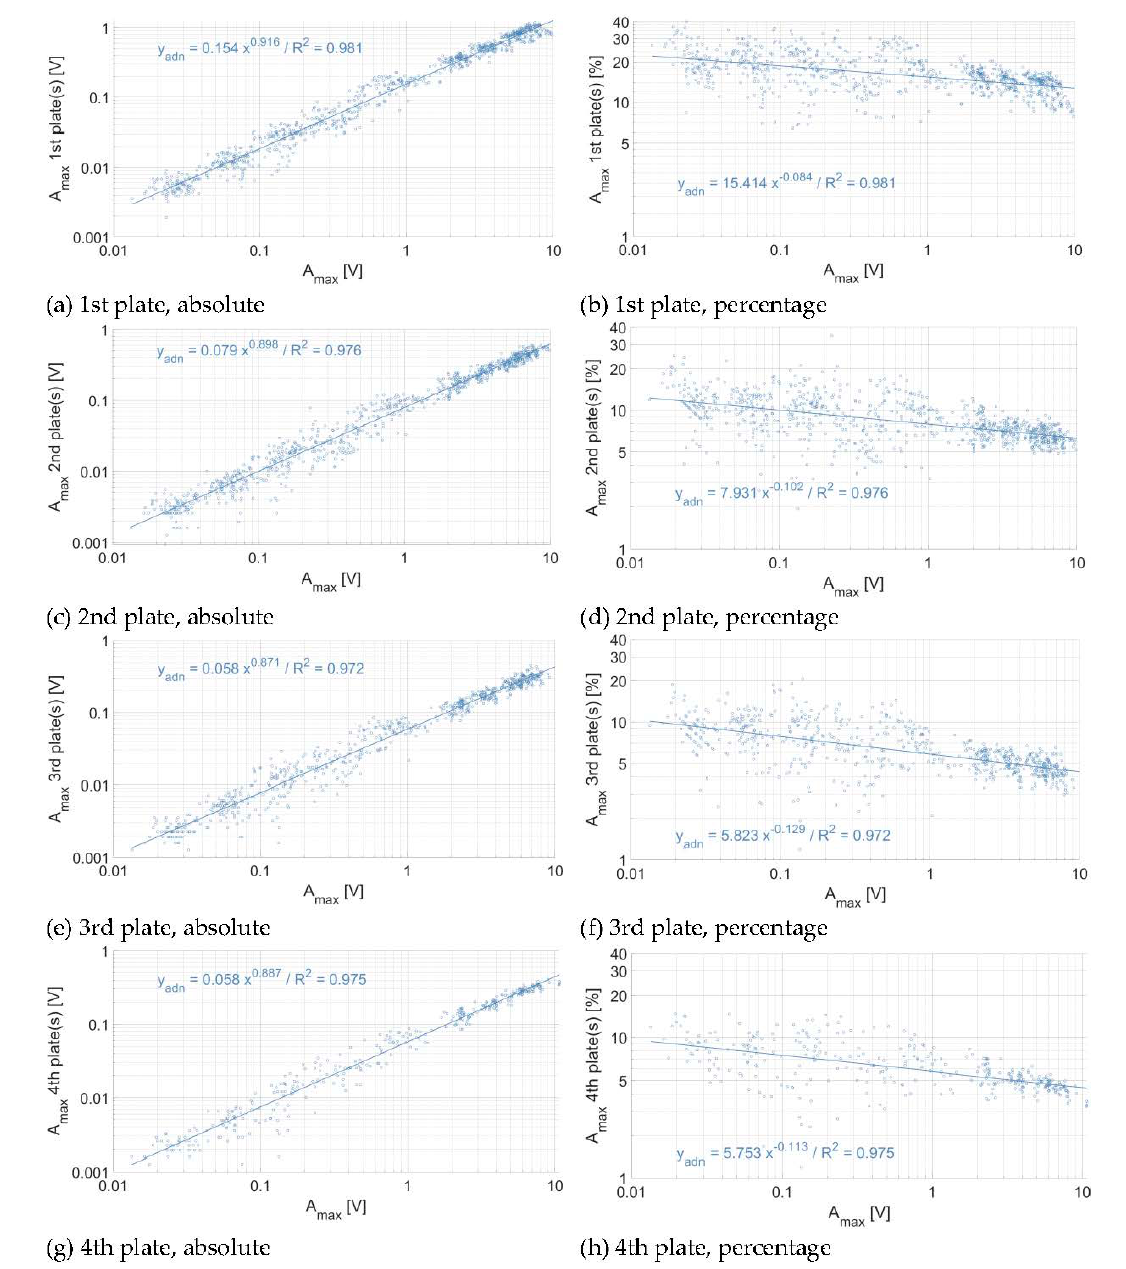
Figure 7. Energy propagation across plates at the Avançon de Nant measuring station ( a , b ) at one plate of distance, ( c , d ) at two plates of distance, ( e , f ) at three plates of distance, and ( g , h ) at four plates of distance, in absolute (left column) and relative (right column) numbers. Each dot represents the voltage associated to an individual impact.